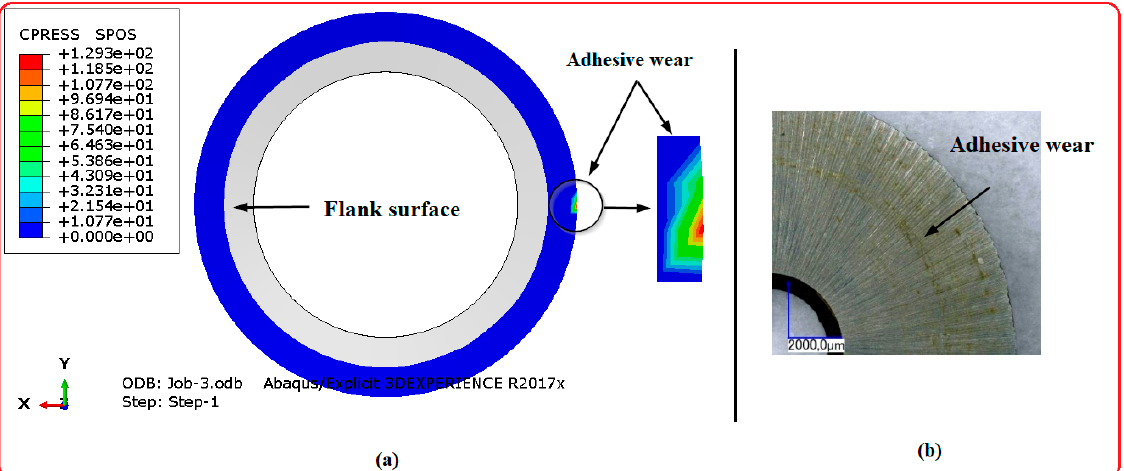
Figure 8. Topographical analysis of the adhesive strip on the flank surface of the saw blade (2000 rpm, 200 mm/min): ( a ) numerical result; ( b ) experimental result.